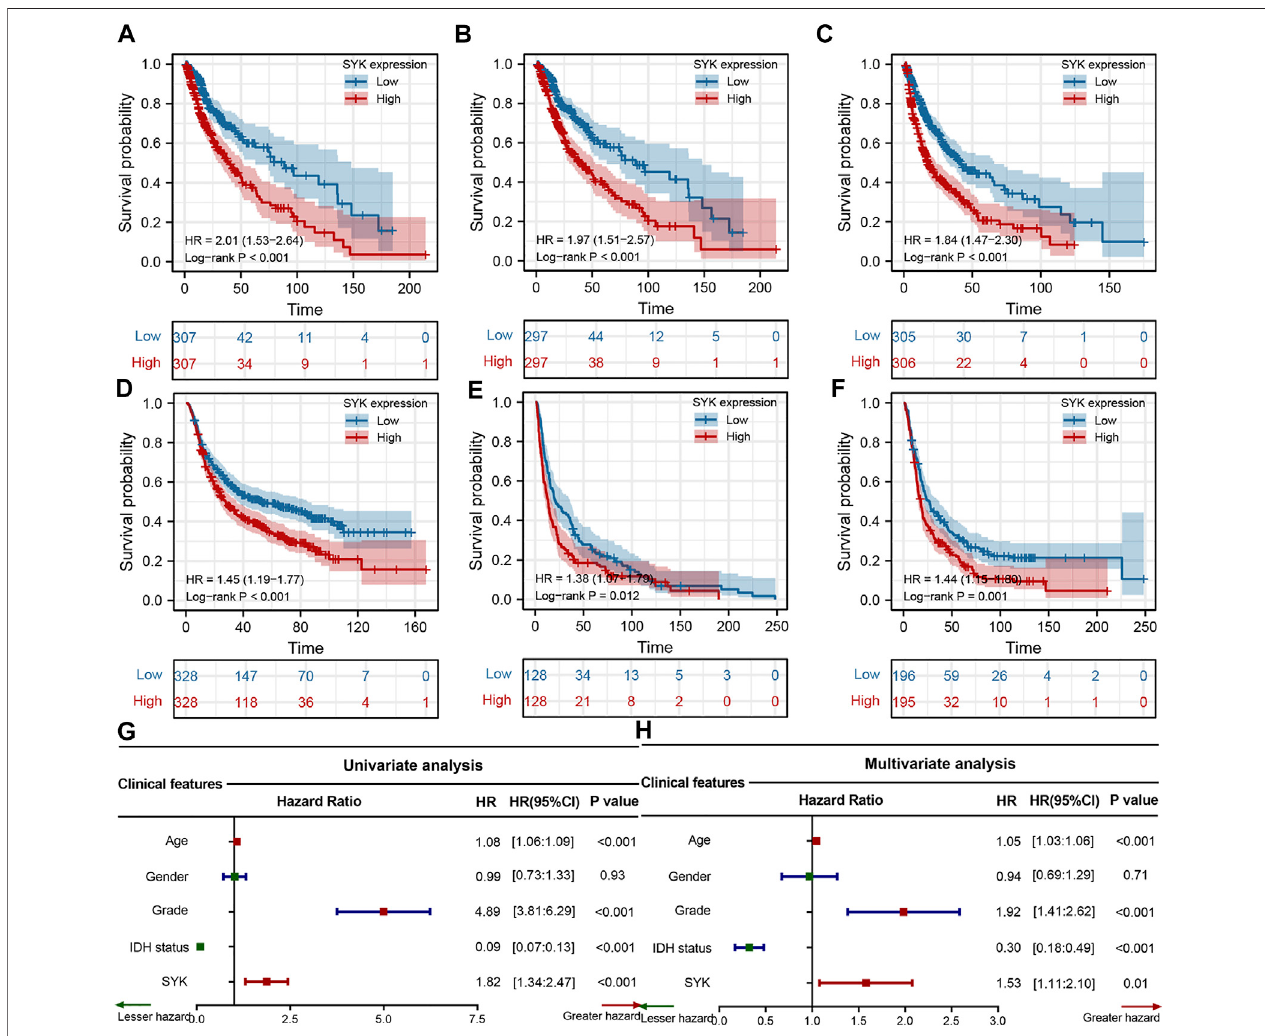
FIGURE 3 | Survival analysis of SYK in the four cohorts. (A – C) The Kaplan – Meier curves displayed the correlation between SYK expression and OS (A) , DSS (B) , and PFI (C) indiffuse gliomas. (D – F) Kaplan – Meier curves showthe correlation between SYK expression and OS ofpatients inthe CGGA cohort (D) , GSE16011 cohort (E) , and Rembrandt cohort (F) . (G – H) The univariate and multivariate Cox regression analyses of SYK expression in the TCGA cohort. p values were calculated by the log-rank test, and p < 0.05 was considered signi fi cant.